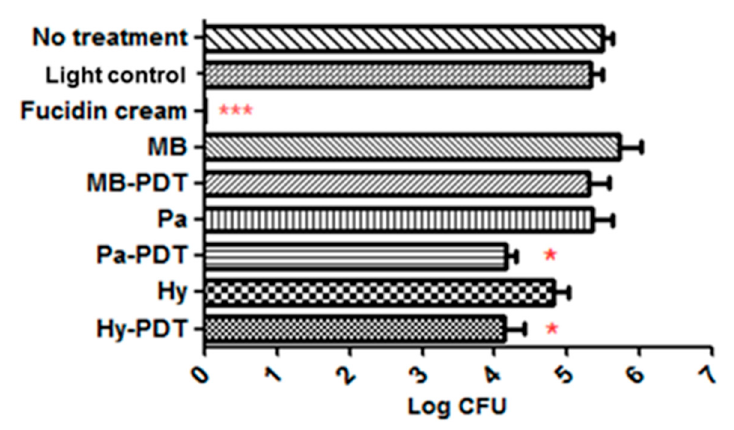
Figure 7. Bacterial load of wounds in different groups of mice after topical treatment with or without PDT. Data are mean ± SEM ( n = 6–10).* p < 0.05 and *** p < 0.001 indicated significant bacterial load difference between No treatment and treatment groups by Student’s t -test.